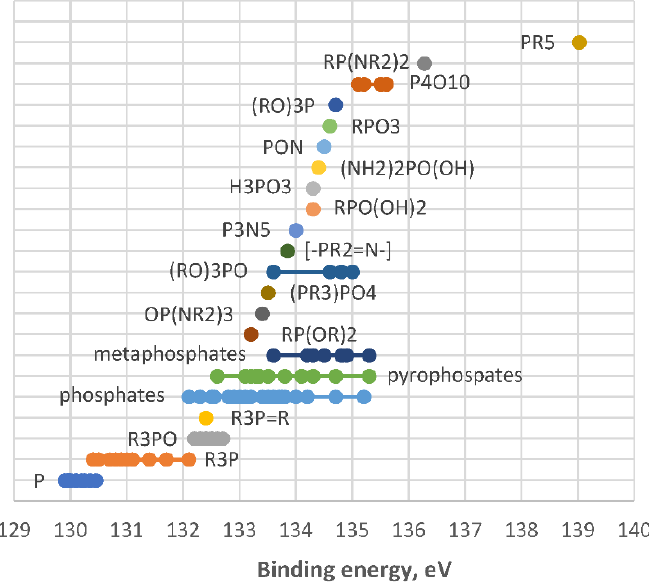
Figure 6. P 2p 3/2 binding energies of different types of phosphorus-containing compounds. Data from NIST X-ray Photoelectron Spectroscopy Database